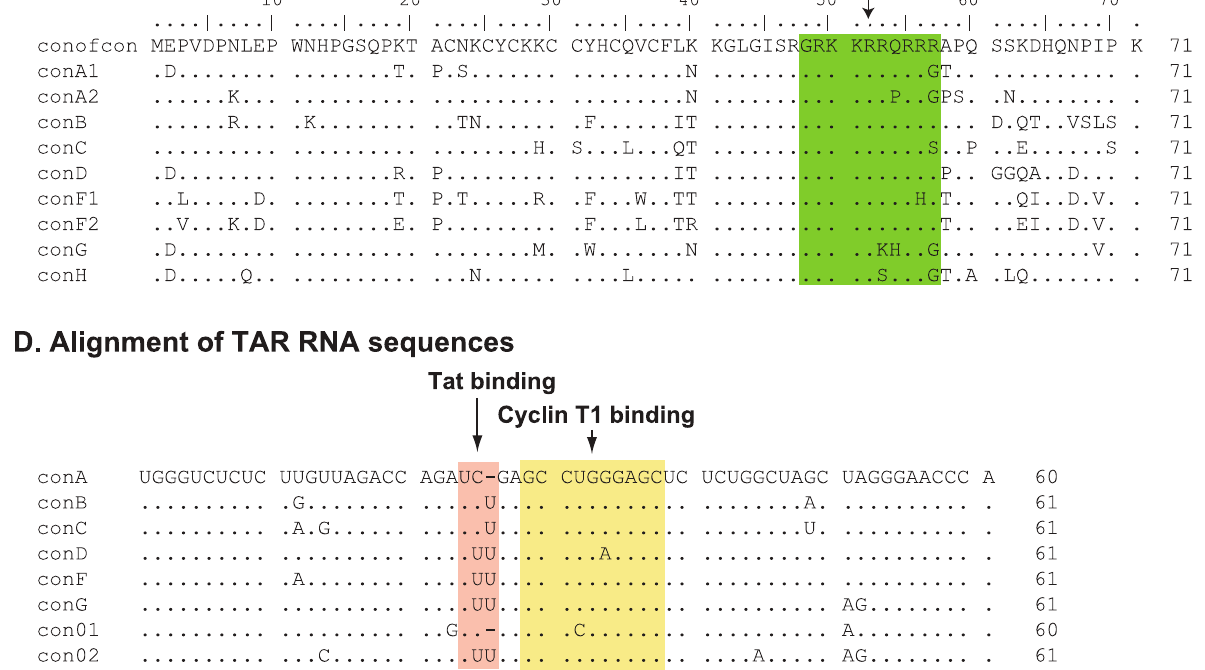
Figure 1. The structure and sequence of HIV-1 Tat/TAR RNA. A schematic of the secondary RNA structure of HIV-1 TAR is presented in panel ( A ) to describe the relative positioning/interaction with HIV-1 Tat, Cyclin T1, and CDK9. The sites of nucleotide sequence variability among HIV-1 isolates are indicated by the arrows. The bracketed letter or number associated with the polymorphism defines the HIV-1 subtype or circulating recombinant form, CRF (respectively). ( B ) The NMR structure of HIV-1 TAR complexed with a small molecule (RBT203) is shown in a space filling model (PDB file 1UUD in ball-and-stick). ( C ) Amino acid alignment of the consensus sequences of HIV-1 Tat proteins from all group M HIV-1 subtypes, which are responsible for the worldwide epidemic. ( D ) The consensus nucleotide sequence of the HIV-1 TAR RNA element in the various HIV-1 subtypes.